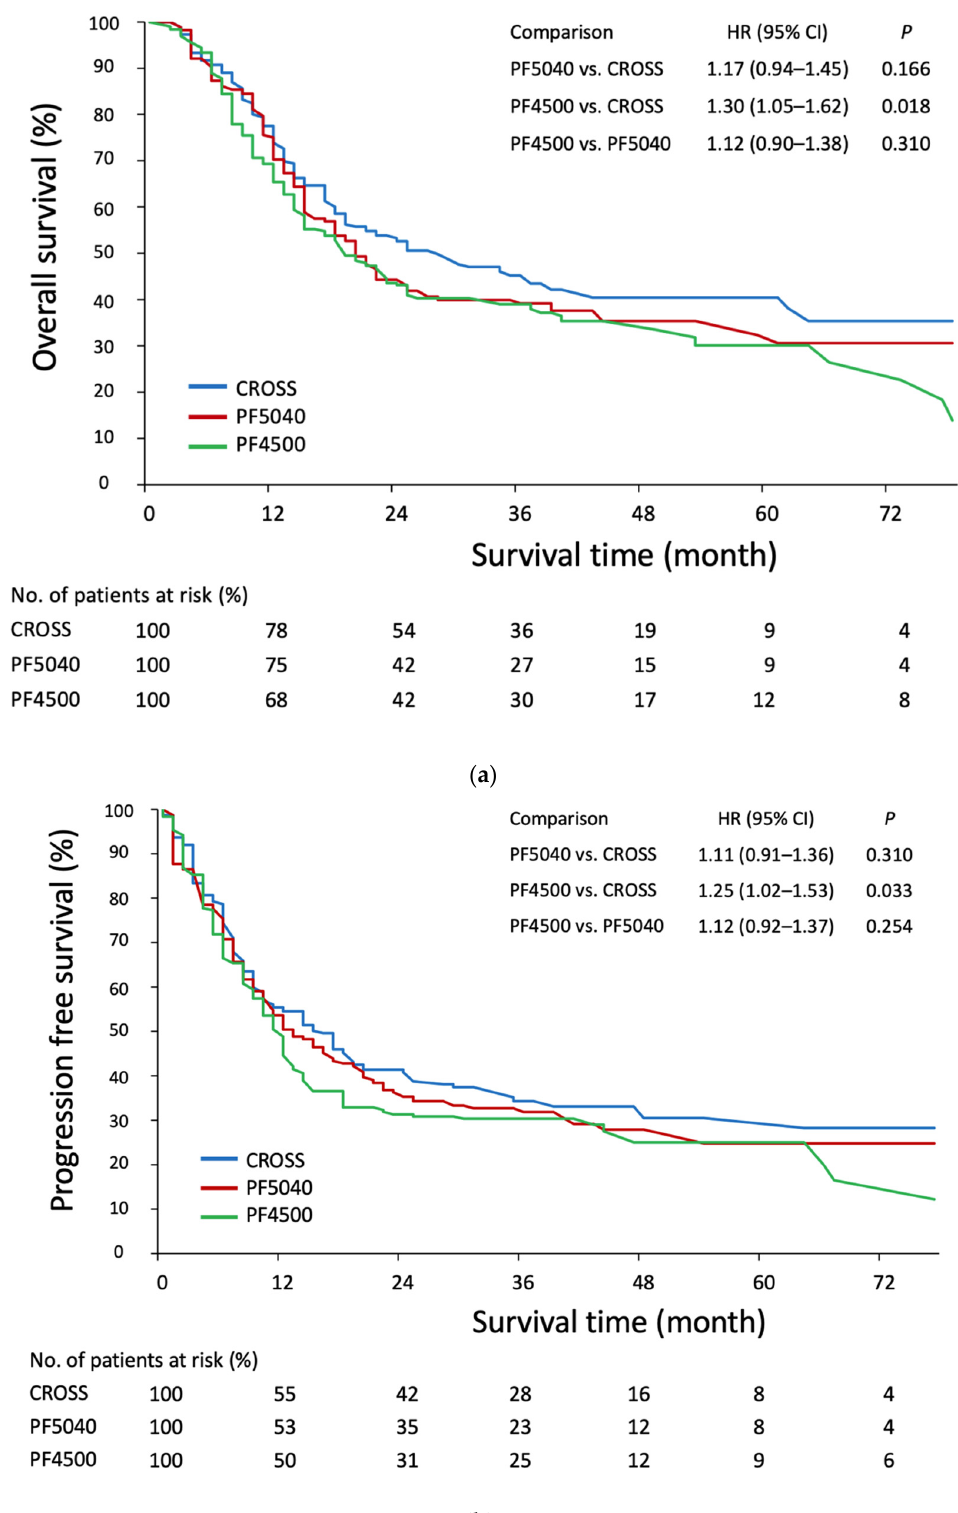
Figure 1. ( a ). Kaplan–Meier estimates of overall survival in the GBM-IPTW adjusted cohort, stratified according to the three nCRT protocols. ( b ) Kaplan–Meier estimates of progression-free survival in the GBM-IPTW adjusted cohort, stratified according to the three nCRT protocols. Abbreviations: GBM-IPTW, generalized boosted modeling-inverse probability of treatment weighting; HR, hazard ratio; CI, confidence interval.